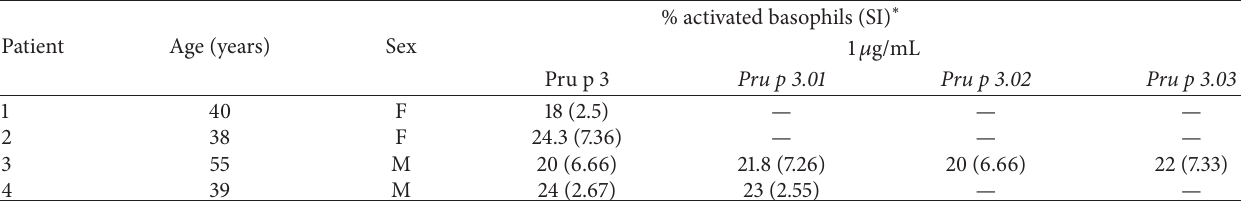
Table 1: Demographic data and basophil activation to the native and mutant forms of Pru p 3 in patients with peach allergy.